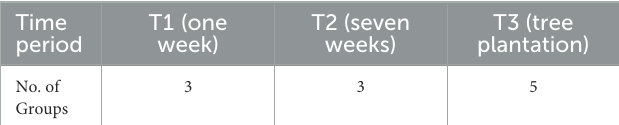
TABLE 4 Intergenerational and intragenerational contributions of experiment